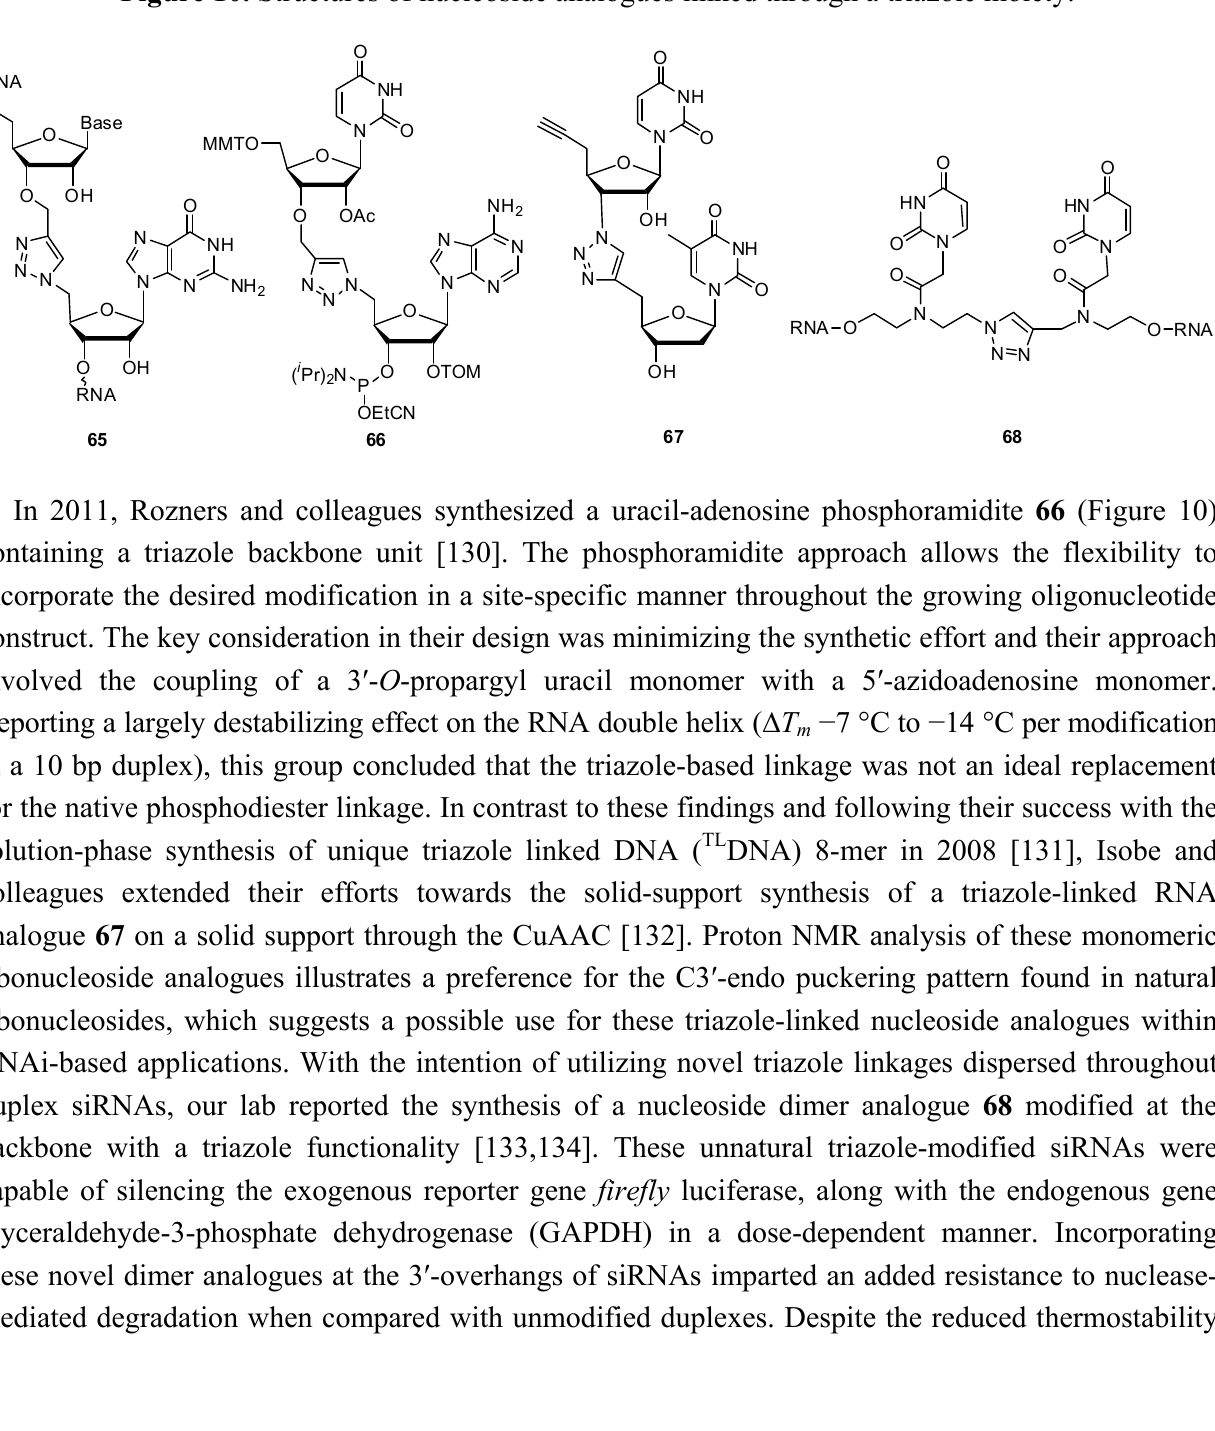
Figure 10. Structures of nucleoside analogues linked through a triazole